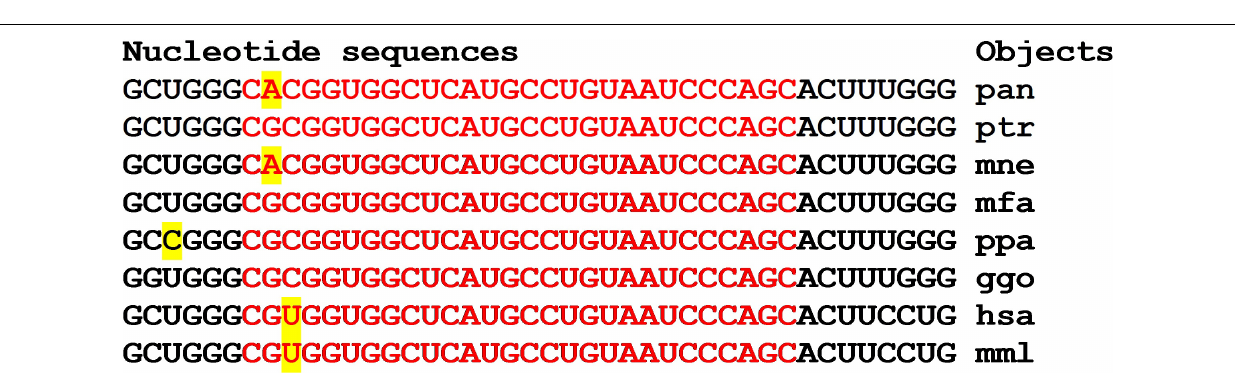
FIGURE 13 | Nucleotide sequences of 3 (cid:48) UTR regions of mRNAs of orthologous SLC14A1 genes containing clusters of miR-5095 and miR-619-5p BSs.